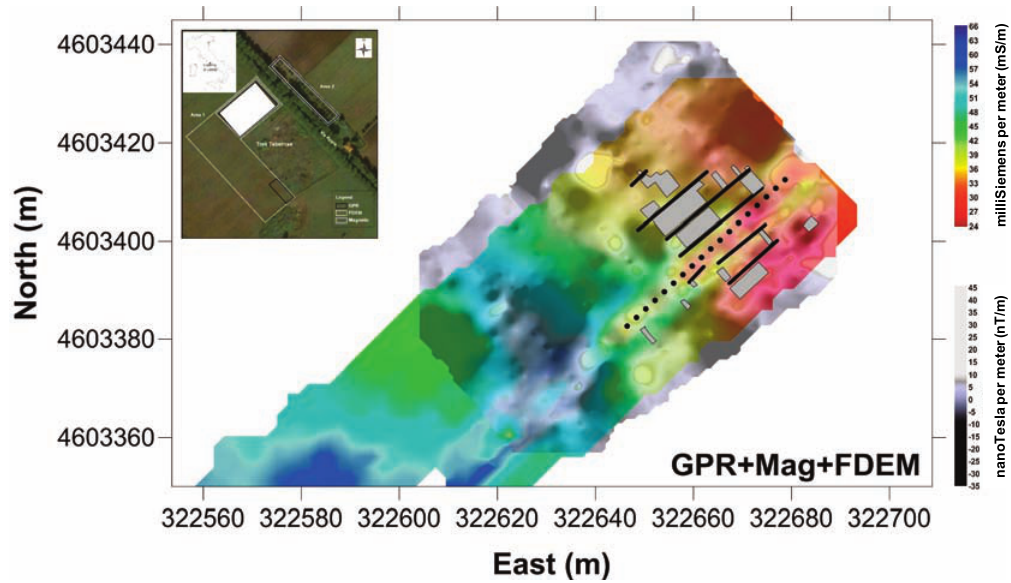
Figure 5. Map of the overlay of the FDEM and the GPR and magnetic methods. Inset, as for Figure 1, for direct